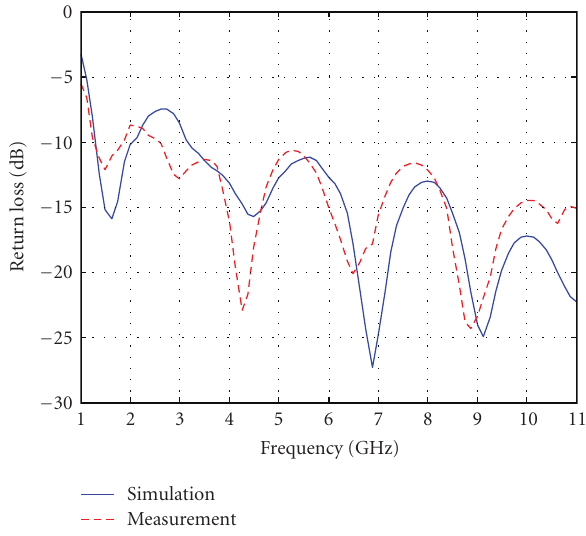
Figure 4: The measured and simulated return